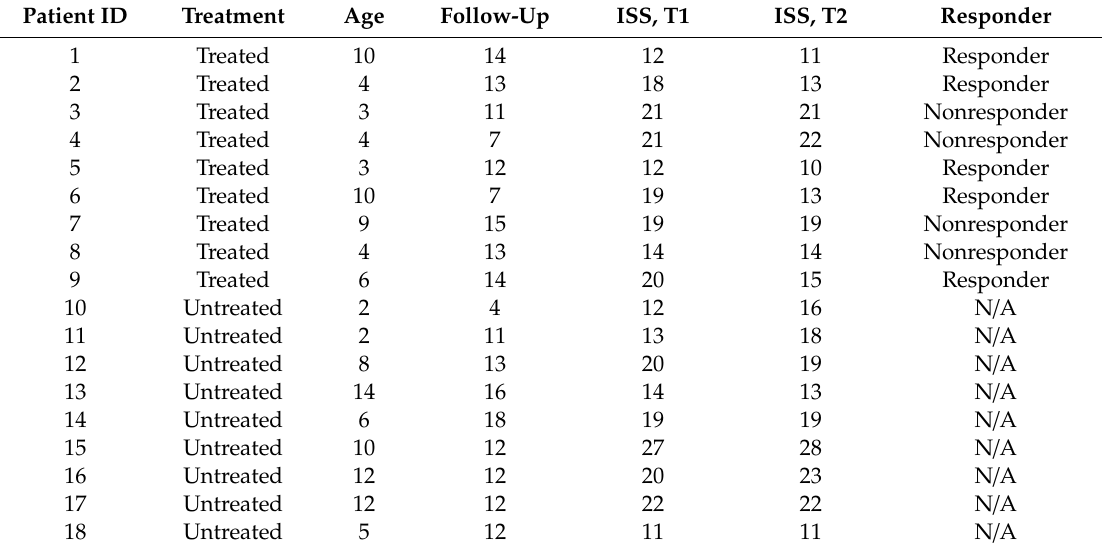
Table 1. Demographic